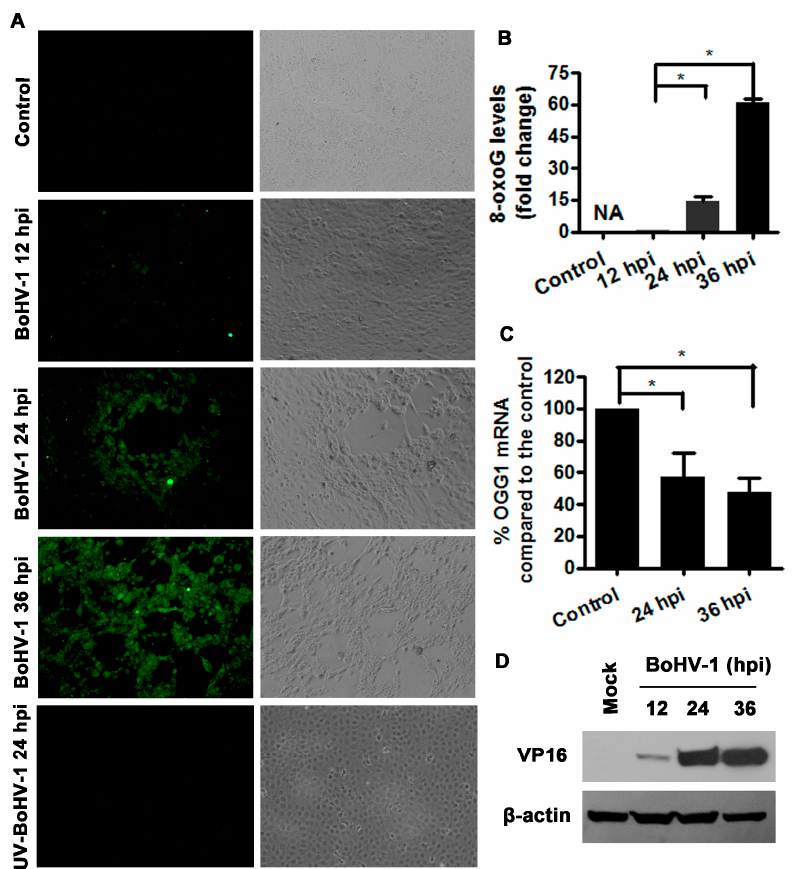
Figure 3. BoHV1 infection increased the levels of oxidative DNA damage marker 8-oxoG. ( A ) MDBK cells were infected by either BoHV-1 or UV-inactivated virus for designated periods. The production of 8-oxoG was detected with immunofluorescence assay. Images shown were represent of three independent experiments (Magnification × 200). ( B ) Fluorescence intensity of three images from each sample was analyzed with software image J. The relative fold change was calculated by normalization to the value of 12 h after infection which was arbitrarily set as 1. NA, not analyzed. ( C ) Total RNA